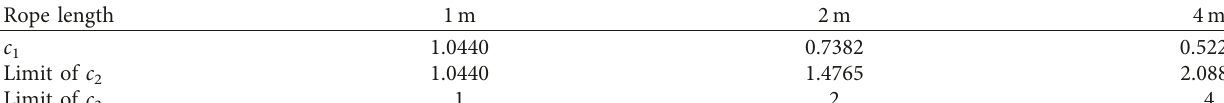
Table 2: c 1 and limits of c 2 and c 3 .